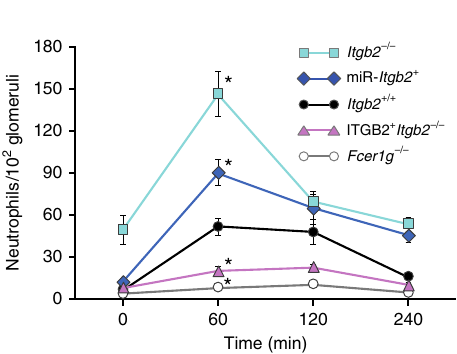
Fig. 6 Regulation of neutrophil accumulation and injury in anti-GBM induced nephritis by CD18 integrins. Wild-type mice ( Itgb2 + / + ) and mice lacking all CD18 integrins ( Itgb2 − / − ), lacking all Fc γ Rs ( Fcer1g − / − ), de fi cient in CD18 only in neutrophils due to neutrophil selective CD18 silencing (miR- Itgb2 + ) or CD18 expression only in neutrophils of the CD18 de fi cient mice (ITGB2 + Itgb2 − / − ) were given anti-glomerular basement membrane antisera and glomerular neutrophil accumulation was evaluated at the indicated time points ( n = 4, 4 – 10, 4 – 8, 4 – 6 mice of each genotype at 0, 60, 120, 240min, respectively). Data is average±SEM. Signi fi cant difference ( p <0.001) among all mouse strains was evaluated by ANOVA. *indicates mouse strains compared to Itgb2 + / + at 0.05 signi fi cance by Bonferroni